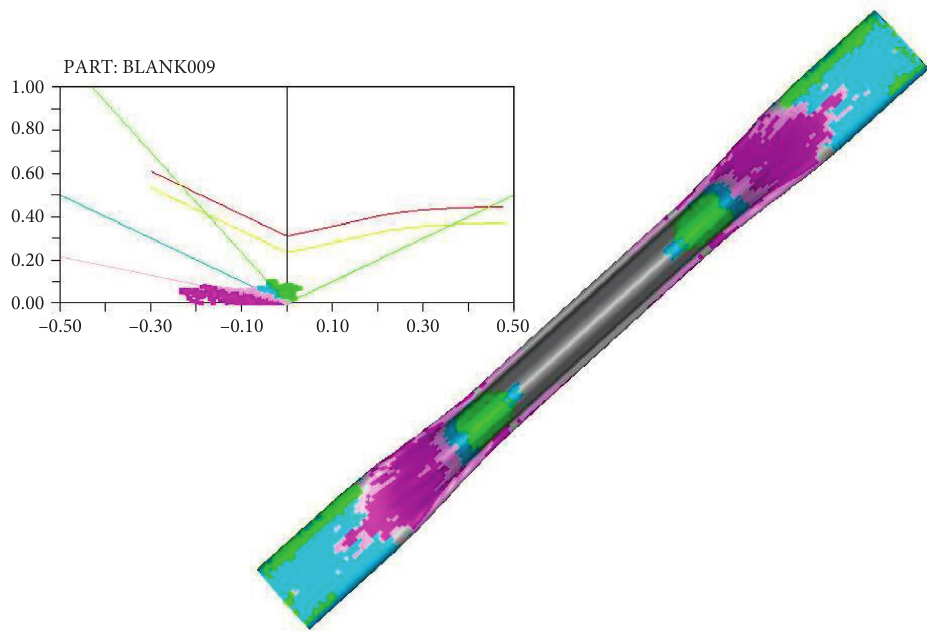
Figure 16: FLD of A